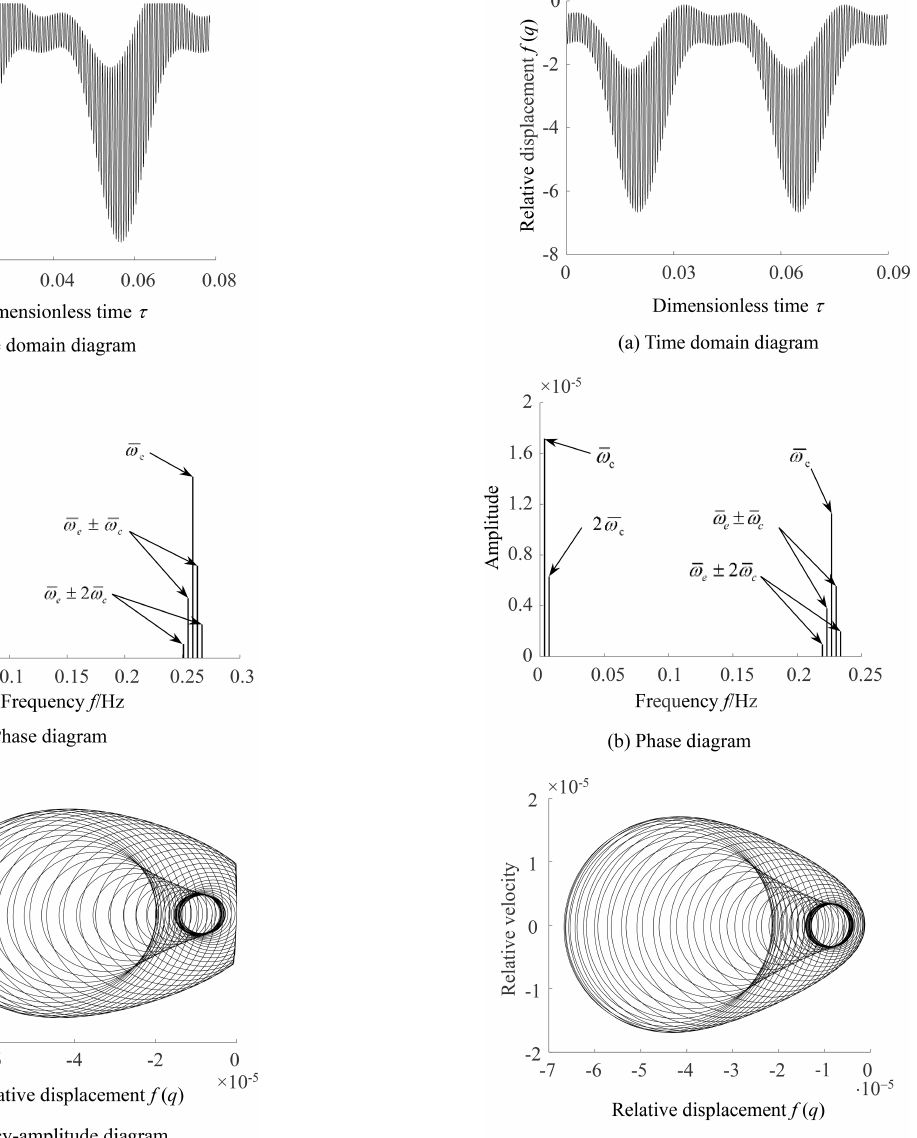
Figure 8. Dynamic response with ω 1 = 160rad per second. frequency vibration.